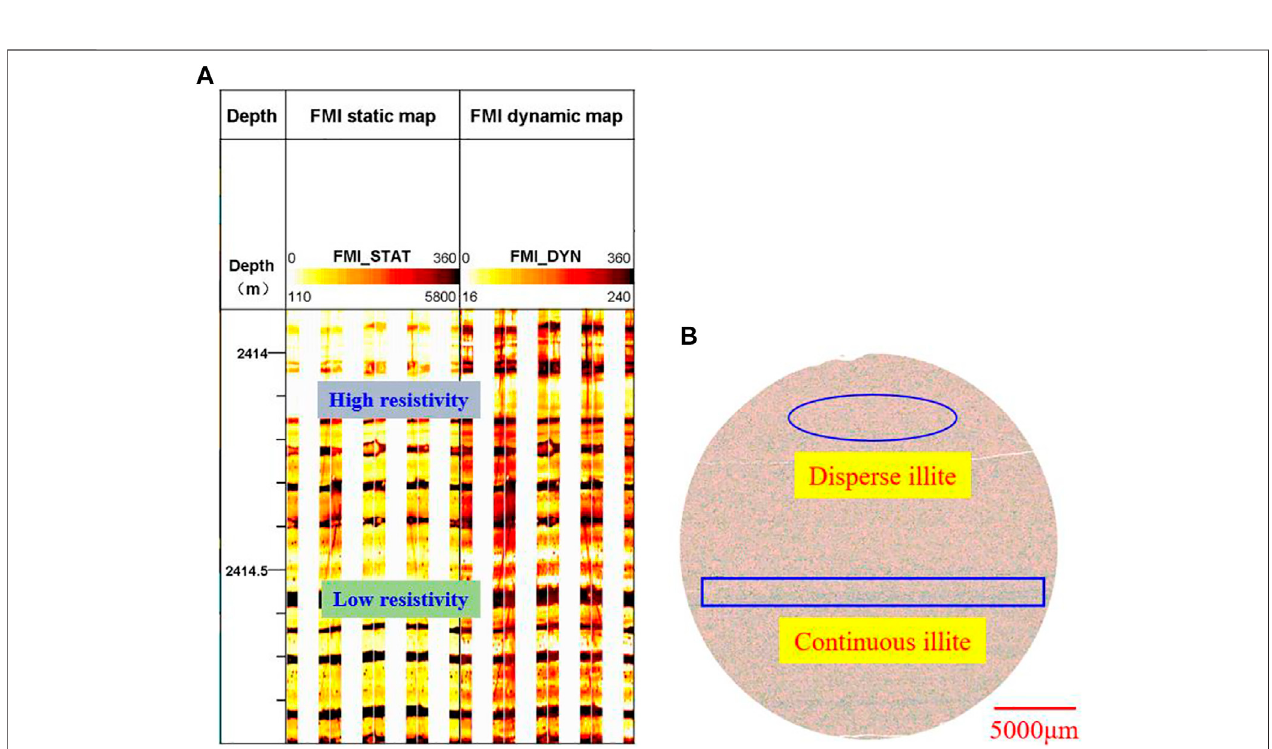
FIGURE 13 | (A) High-resistivity and low-resistivity layers in the FMI image; (B) Mineral image.